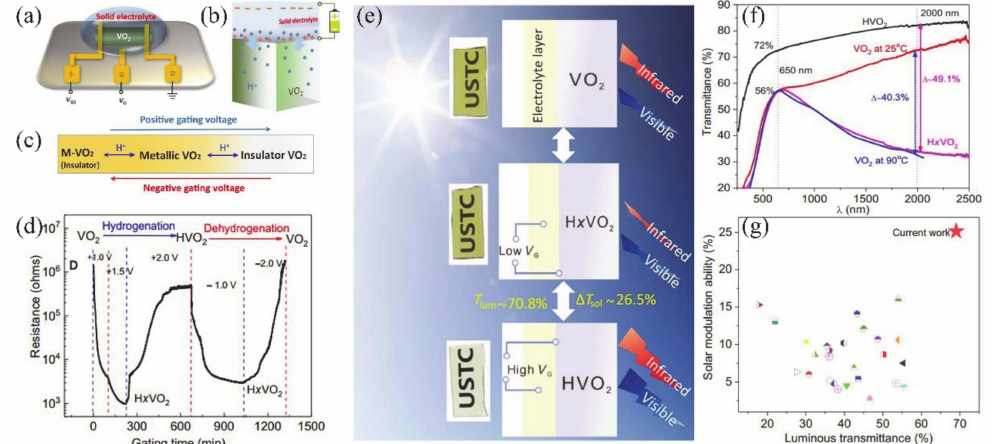
Figure 22. ( a ) Schematic of an electrochromic smart window device based on VO 2 film for solid-state electrolyte gate voltage control. ( b ) Illustration of hydrogen ion movement under gating control and ( c ) reversible insulator-metal–insulator tristate phase transitions about VO 2 . ( d ) The reversible phase modulations by different voltages as a function of gating time. ( e ) Schematic diagram of electrochromic smart windows. ( f ) Optical transmittance spectra of VO 2 , H x VO 2 and HVO 2 thin films. ( g ) Plot of luminous transmittance T lum versus solar modulation ability ∆ T sol . The data of this work are marked with (cid:70) . Reproduced from [11], with permission from American Association for the Advancement of Science,